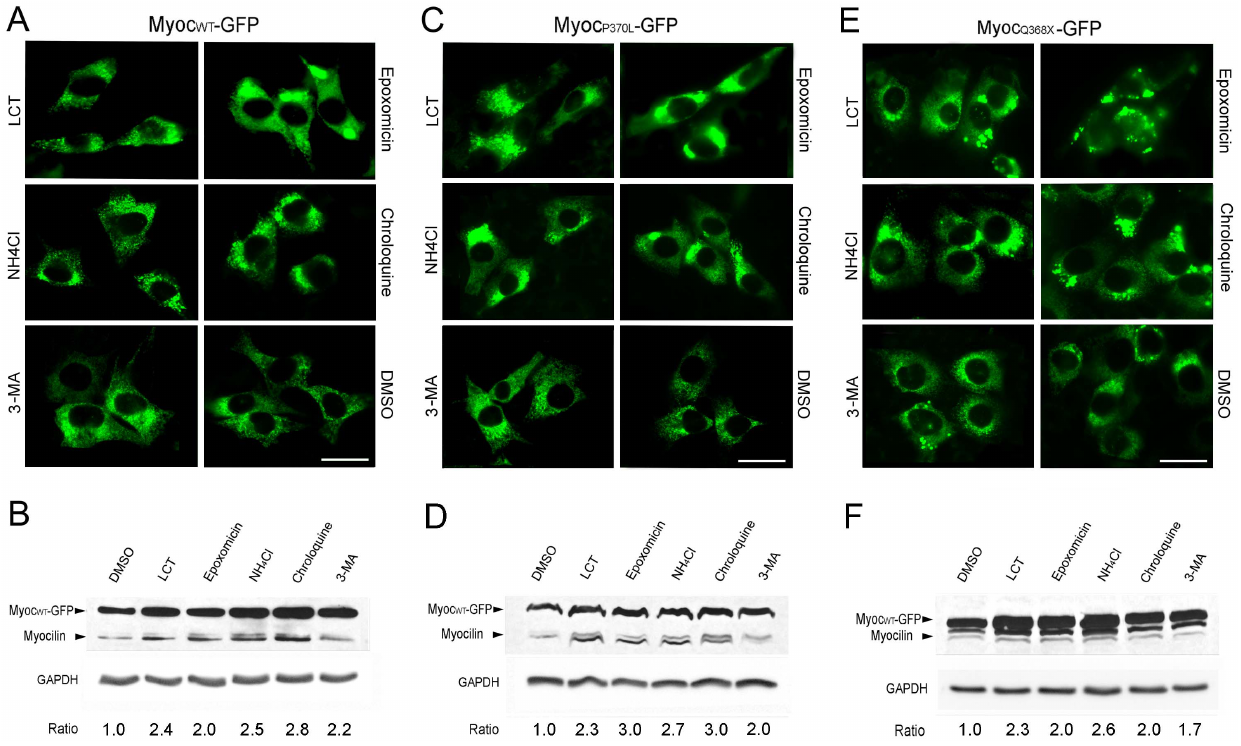
Figure 6. Effects of inhibitors on levels of expressed myocilin-GFP in inducible cells. Fluorescence images of myocilin WT -GFP (Myoc WT -GFP, A ), myocilin P370L -GFP (Myoc P370L -GFP, C ), myocilin Q368X -GFP (Myoc Q368X -GFP, E )-expressing-RGC5 cells treated with various inhibitors are shown. Scale bar, 20 m m. For Western blotting, RGC5 cells induced by Dox for 24 h to express myocilin WT -GFP ( B ), myocilin P370L -GFP ( D ), and myocilin Q368X - GFP ( F ) were treated for 16 h with vehicle DMSO, or proteasomal (LCT and epoxomicin), lysosomal (NH 4 Cl and chloroquin) or autophagic (3-MA) inhibitors. Proteins (25 m g) in cell lysates were immunoblotted with anti-myocilin or anti-GAPDH. Protein bands for the endogenous myocilin (55/ 57 kDa) and myocilin-GFP ( , 100 kDa) were seen. Densitometry was performed. The myocilin-GFP/GAPDH relative to the DMSO control ratios are presented. All experiments were repeated at least 3 times.